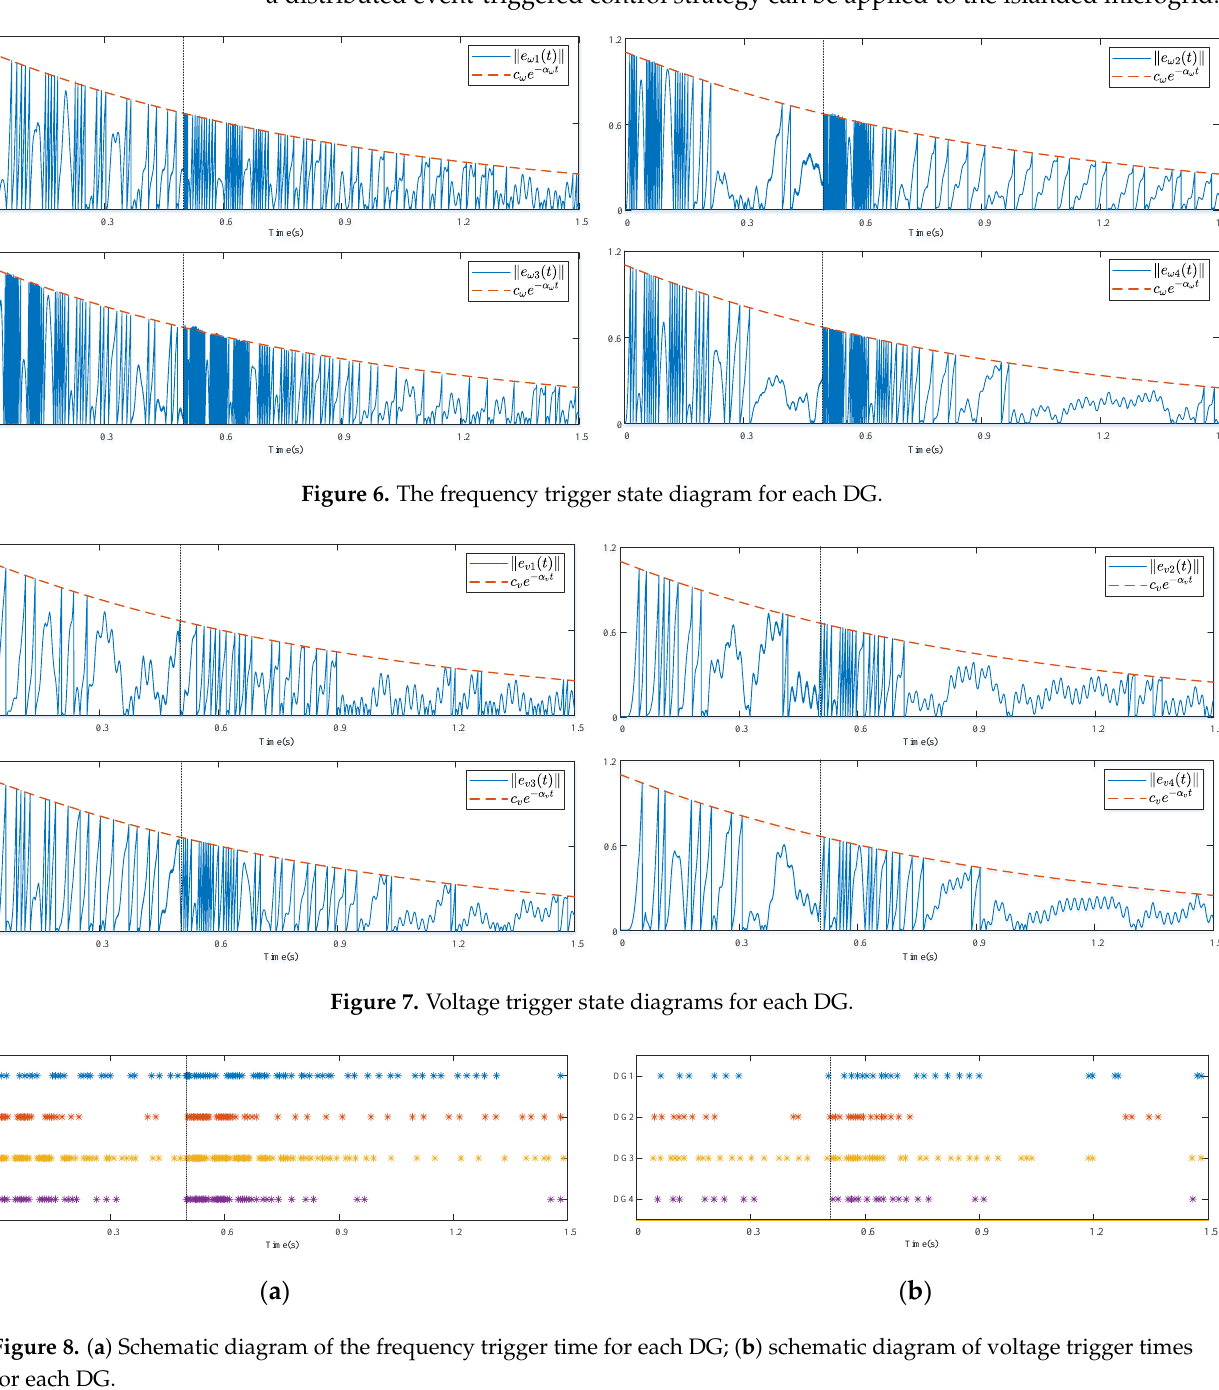
Figure 8. ( a ) Schematic diagram of the frequency trigger time for each DG; ( b ) schematic diagram of voltage trigger times for each DG.